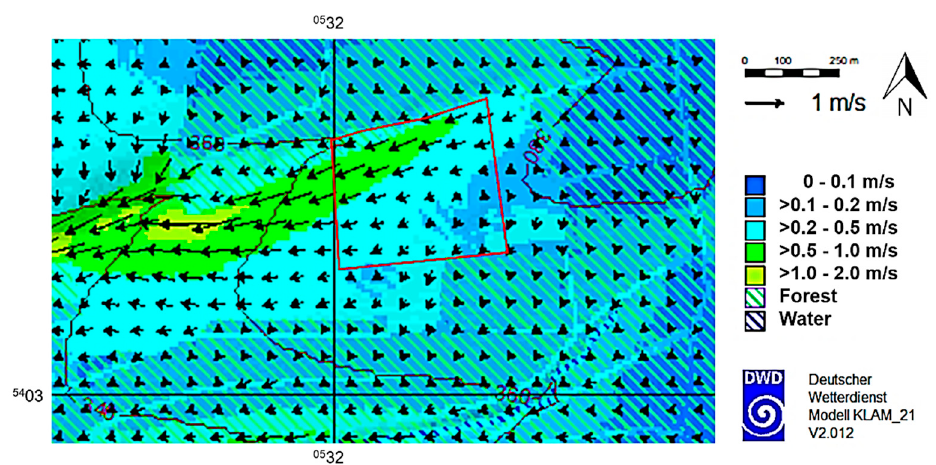
Figure 6. Cold air flows calculated using KLAM_21 (DWD) one hour after sunset. The arrows indicate the magnitude and direction of the flow velocity as an elevation average. The outline of the plantation is marked in red.